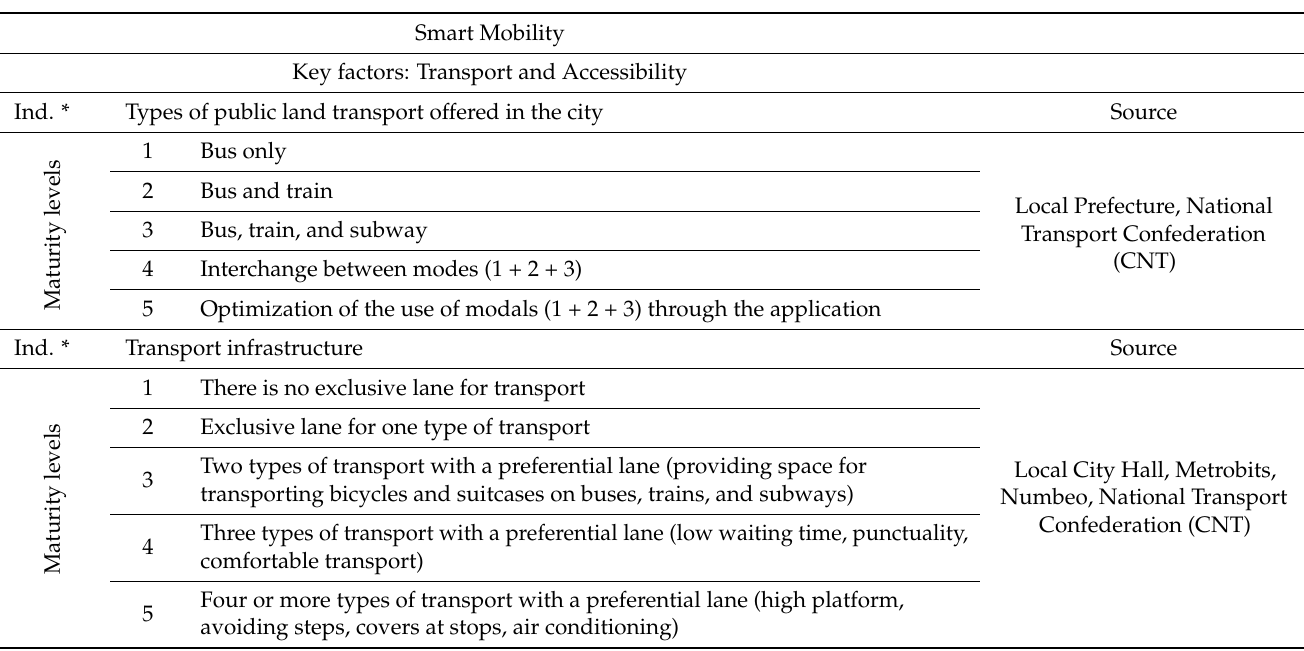
Table 3. Third round result of the Delphi method: an instrument for assessing logistical maturity in smart